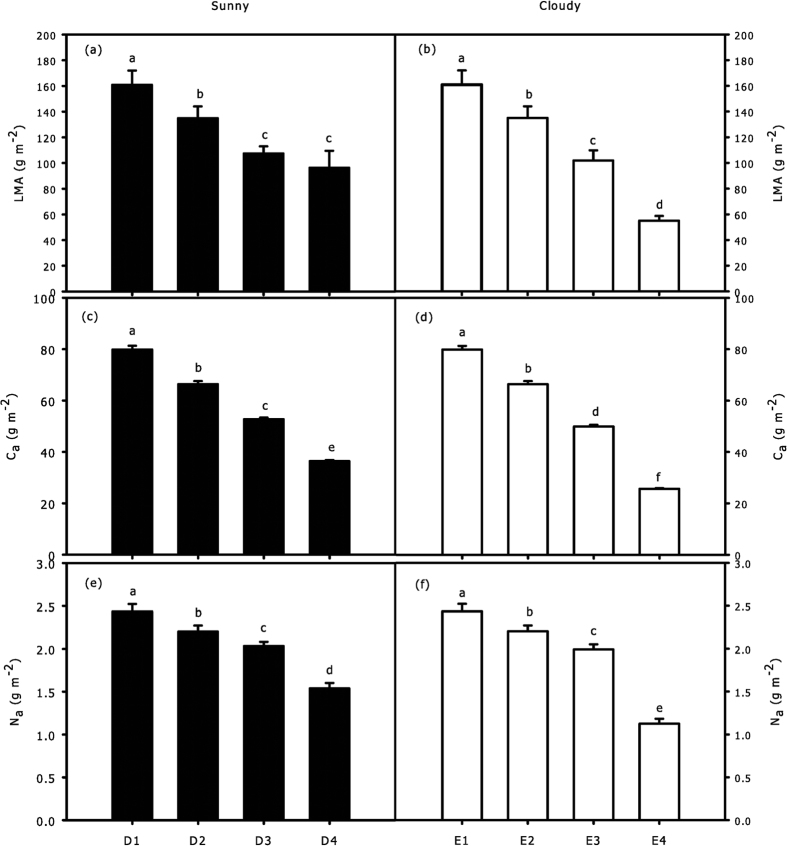
Variation of LMA (a,b), Ca(c,d) and Na(e,f) of leaves between each pair of CEZs (D1, D2, D3, D4 under sunny condition and E1, E2, E3, E4 under cloudy condition) on a crown scale. Identical letters indicate homogeneous groups with statistically insignificant differences (p > 0.05). All values are means ± SE; n = 30.